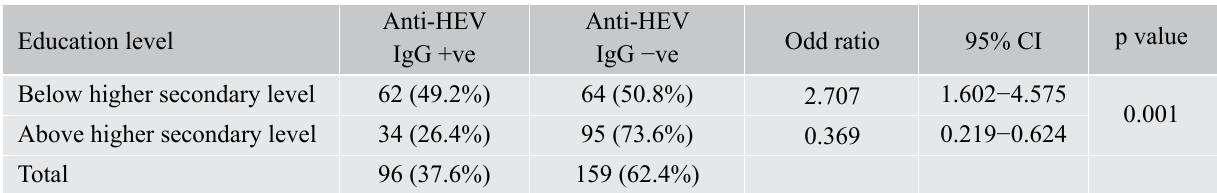
Table III: Odd ratio for HEV seropositivity on the basis of level of education attained by pregnant Education level